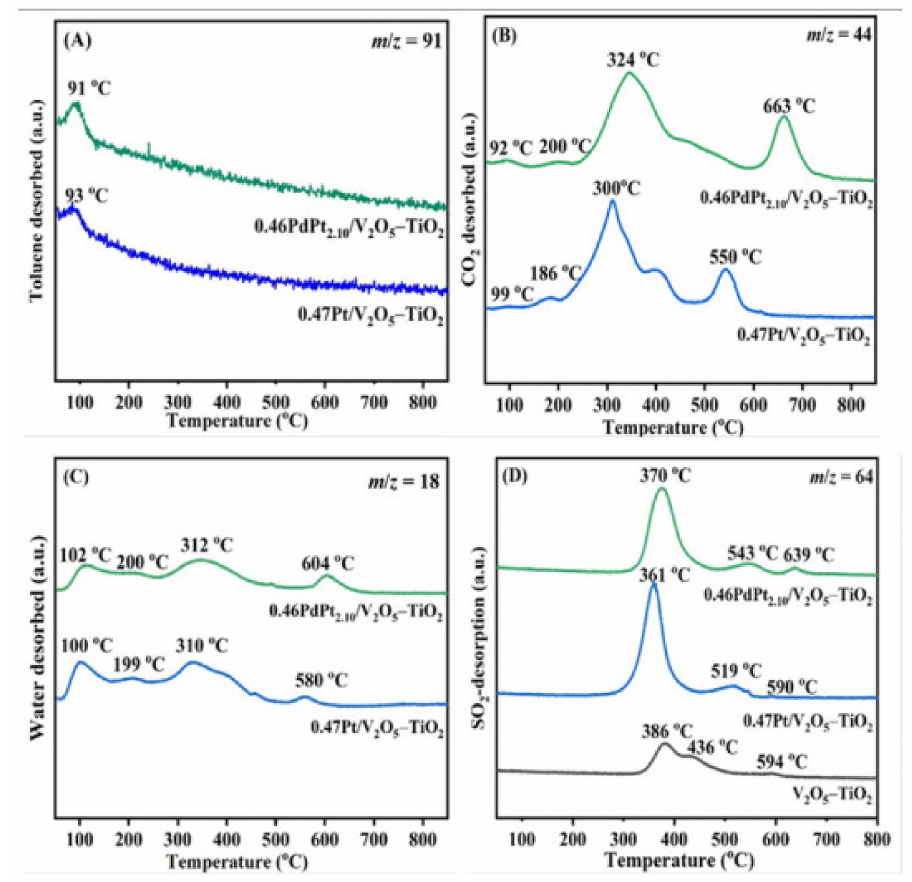
Figure 7. ( A ) Toluene, ( B ) CO 2 , ( C ) water desorption in the toluene-TPD profiles, and ( D ) SO 2 desorption in (C 7 H 8 + SO 2 )-TPD profiles of 0.47Pt/V 2 O 5 -TiO 2 and 0.46PdPt 2.10 /V 2 O 5 -TiO 2